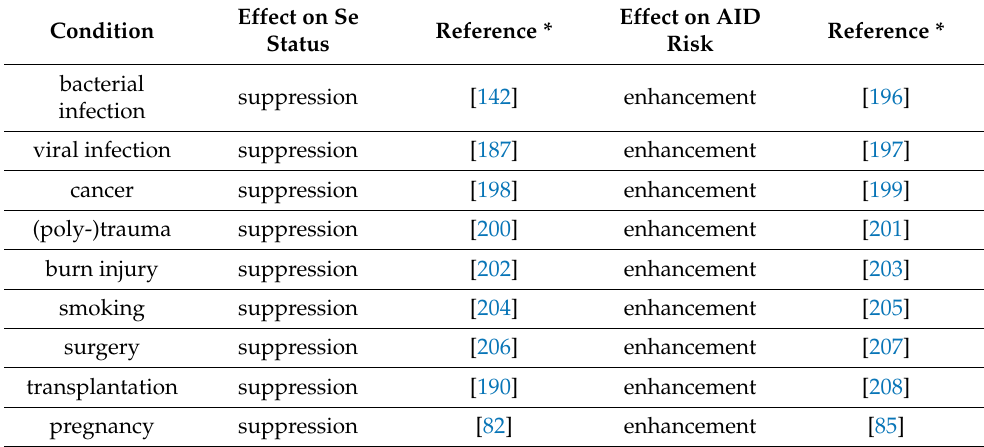
Table 2. Inflammatory conditions associated with decreasing Se status and increasing AID